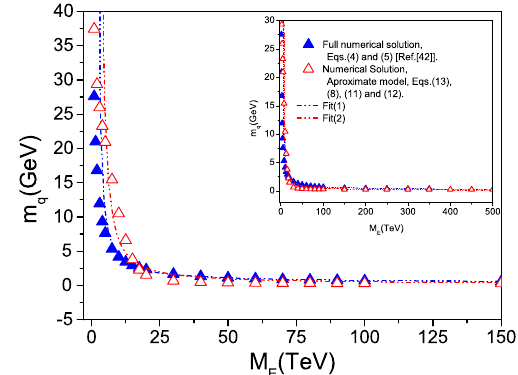
Fig. 2 Behavior of m q as a function of M E obtained from Eq. (13) using the solutions of Eqs. (12) and (11) (red curve ( Δ )). The blue curve ( (cid:2) ) corresponds to the result obtained in [40]. The dot-dash lines represents the Fit(1) (blue dot-dash line) and Fit(2) (red dot-dash line) , the parameters are described in the text